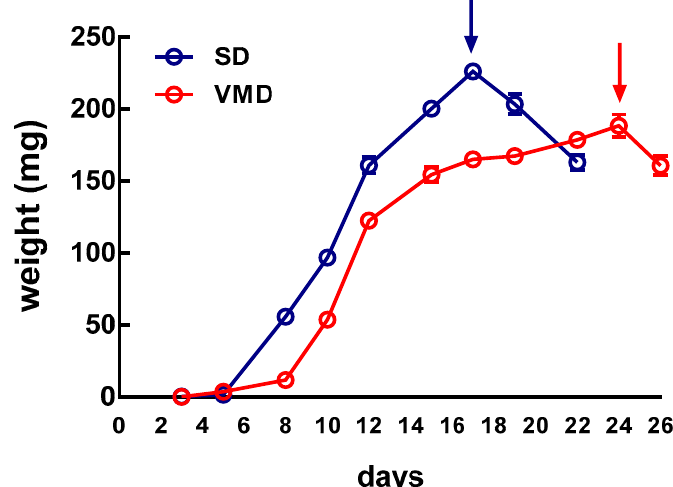
Figure 1. Growth rate of H. illucens larvae. The weight of the larvae reared on di ff erent substrates was recorded until 25% of insects reached pupal stage. The day in which the larvae reached the maximum weight was considered the end of the larval stage (arrows). Then insects entered the prepupal stage and stopped feeding.